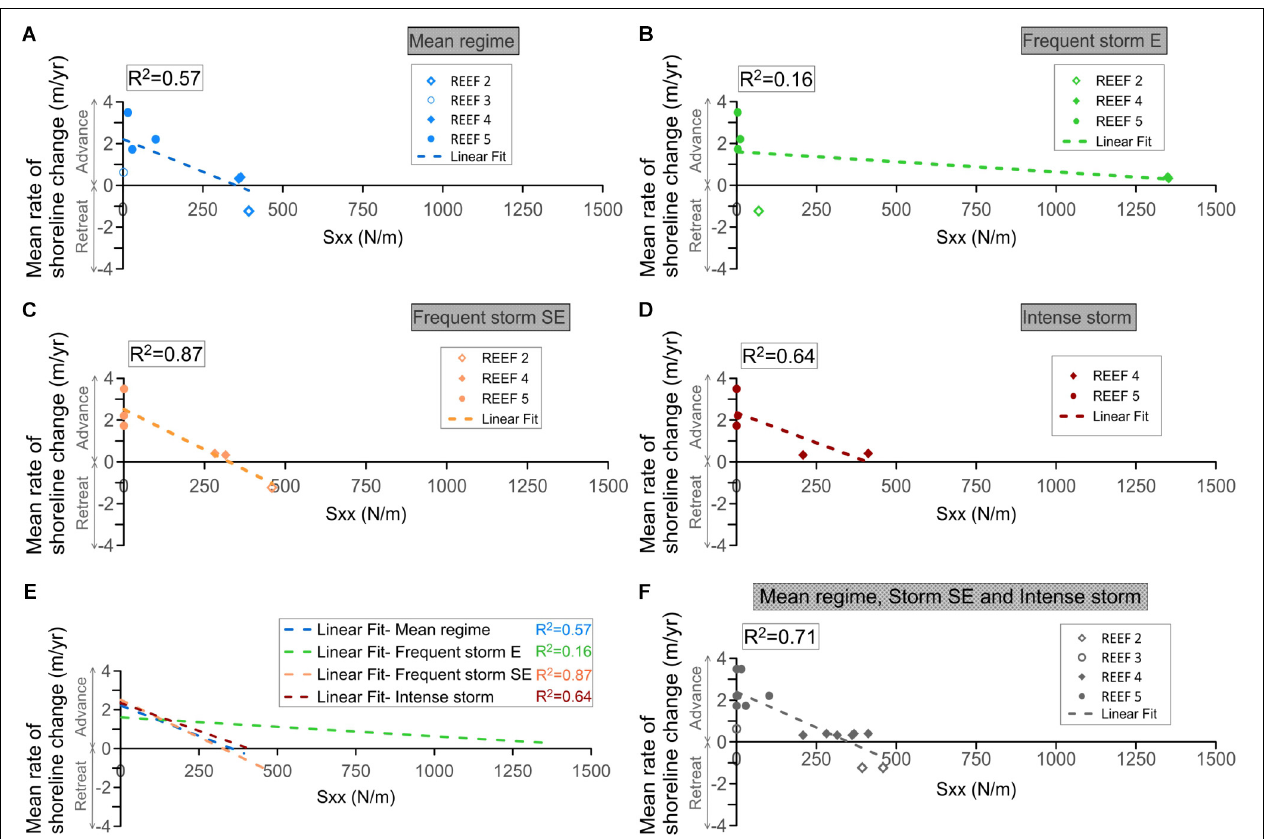
FIGURE 12 | Shoreline change as a function of the radiation stress when waves break near the coastline, for different hydrodynamic forcing: (A) Mean regime. (B,C) Frequent storms. (D) Intense storms. (E) Fitting lines to data for the four wave cases. (F) Mean regime, storms from the Southeast and intense storms. The dashed line represents a linear regression line fitted by least squares. R 2 is the square of the Pearson linear correlation coefficient, tested at 95% confidence